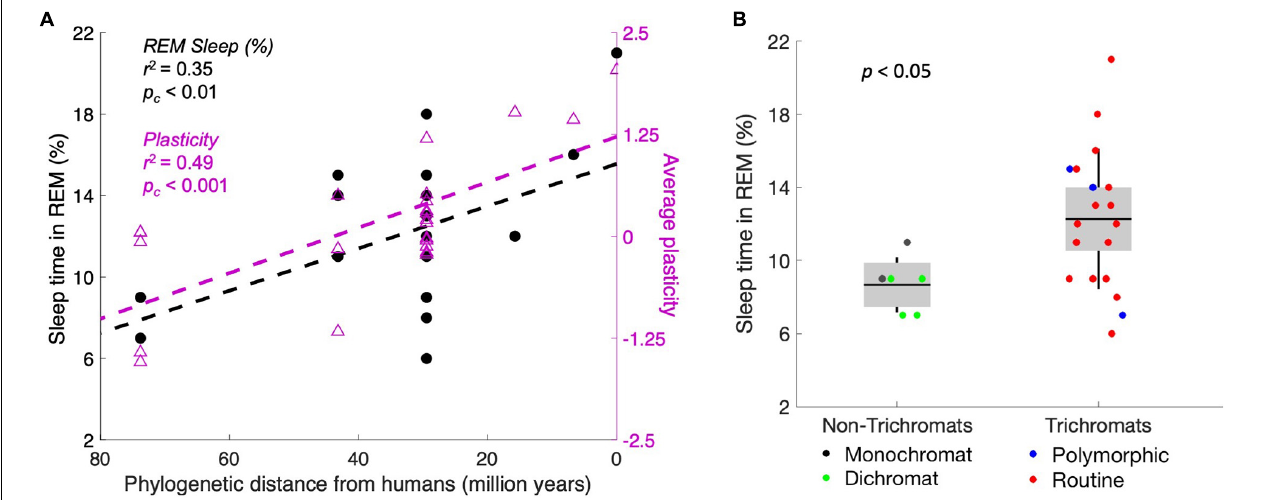
FIGURE 3 | Plasticity and REM sleep increase concomitantly with evolutionary recency to humans. (A) Primates are plotted by recency of common ancestors from humans, with percentage of sleep time in REM (left axis, black markers) and behavioral plasticity index (right axis, purple markers). The correlation is significant for both measures. The two markers at 0 on the x -axis represent homo sapiens. (B) Trichromats average 49% more REM sleep (as a fraction of total sleep time) than monochromats and dichromats. We hypothesize that the increased complexity of the visual system correlates with higher plasticity, which then requires more defense of the visual system during the